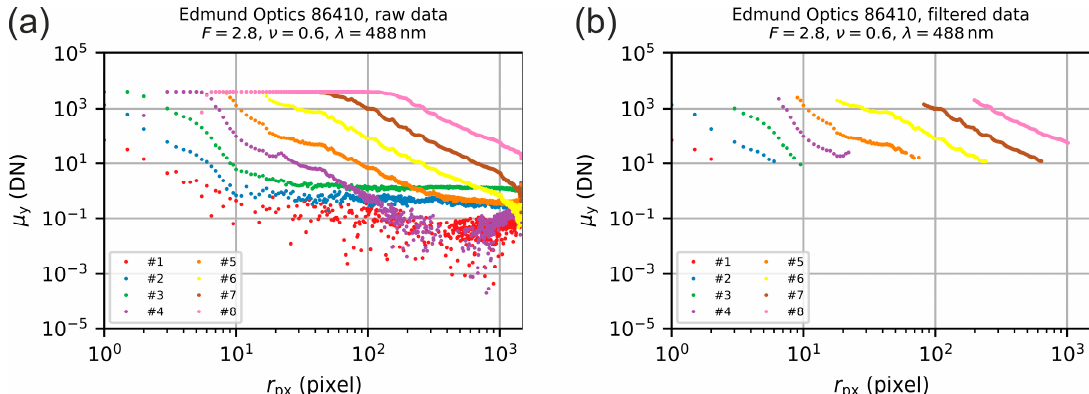
Figure 11. Radial irradiance profile for the camera lens Edmund Optics 86410 ( 𝜆 = 488 nm , 𝐹 = 2.8 ). ( a ) Extracted radial irradiance profiles for the different settings according to Table 4. ( b ) Remaining radial irradiance profiles after discarding values of overexposed and underexposed parts of the images.